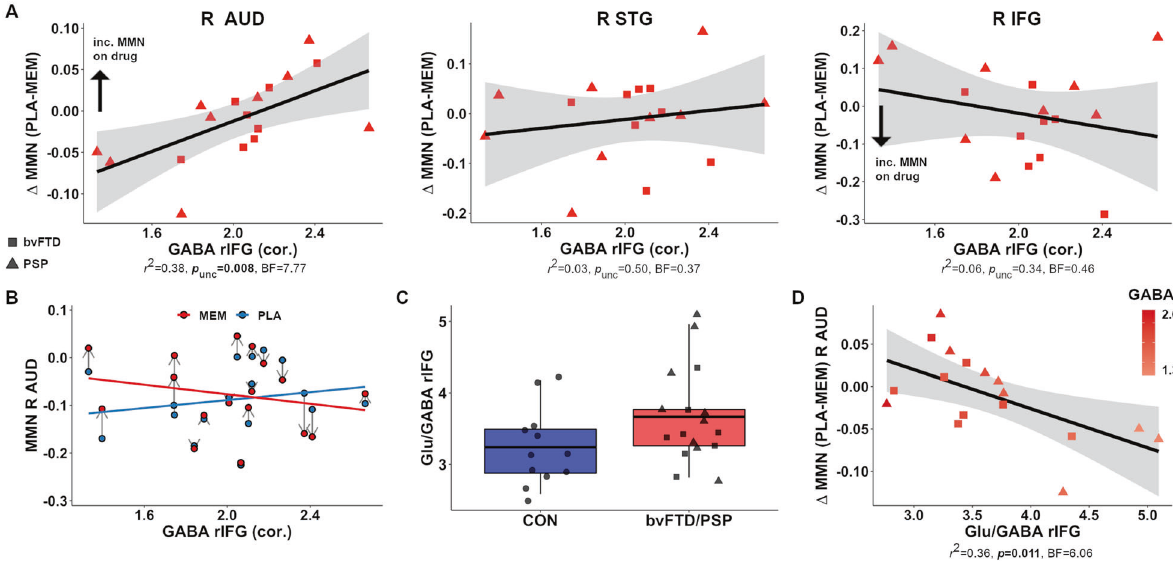
Fig. 4 GABA in fl uences on the response to memantine in patients across source regions. A Association between corrected GABA concentrations in the R IFG and change in MMN to memantine (vs. placebo) across bvFTD (squares) and PSP patients (triangles). B For the right auditory cortex, mean MMN as a function of drug session (Drug, red line and circles; Placebo, blue) and GABA concentration. C Glu/GABA ratios in controls and bvFTD/PSP, with middle line indicating group mean. Boxes represent interquartile range of 25% and 75% percentile, and whiskers the 95% probability density. D Association between the ratio of Glutamate and GABA (Glu/GABA) and change in MMN to memantine (vs. placebo) in the right auditory cortex. Data points are coloured according to baseline GABA levels. bvFTD behavioural variant frontotemporal dementia, PSP progressive supranuclear palsy, R IFG right inferior frontal gyrus, R STG right superior temporal gyrus, R AUD right auditory cortex. PLA placebo, MEM memantine. GABA and Glutamate concentrations corrected for age, sex and partial-volume information.